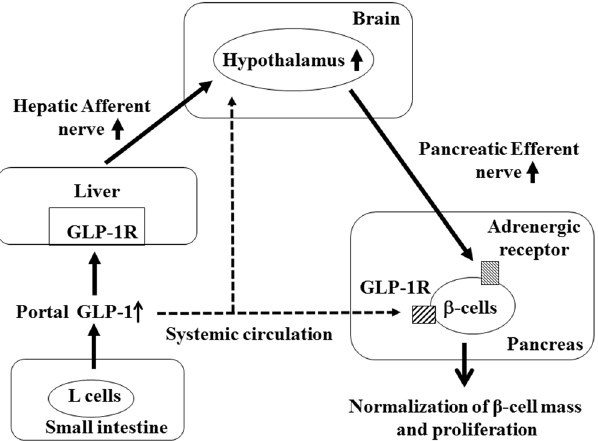
Figure 6. Schematic model of the neuronal relay mediating intra-organ communication. GLP-1 secreted from L cells in the small intestine stimulates the hypothalamus indirectly through the activation of hepatic afferent nerves and directly through crossing the BBB. Activated hypothalamic neurons stimulate efferent nerves innervating the pancreas, which modulate β -cells via adrenergic receptors. In addition, GLP-1 also acts directly on β -cells through